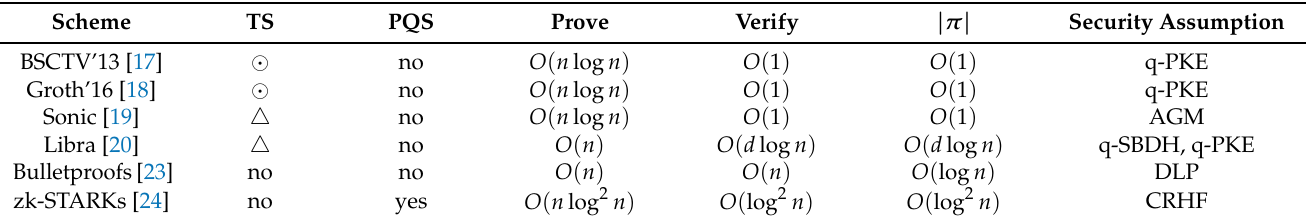
Table 1. Comparison of different ZKP constructions, in regards to their asymptotic efficiency, where n is the number of gates of the circuit and d its depth. (TS = trusted setup, PQS = post-quantum secure, | π | = proof size, (cid:12) = per-statement, (cid:52) =